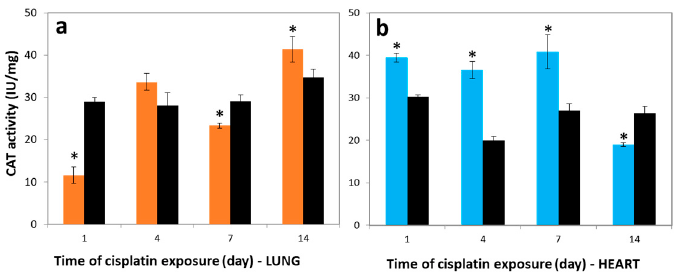
Figure 3. Catalase (CAT) activity in ( a ) lung and ( b ) heart tissues over time. Lung ( ⎯ ⎯ ) and heart ( ⎯ ⎯ ) tissues of treatment group, and controls ( ⎯ ⎯ ). These results are expressed as mean ± SD ( n = 6). *Significantly different ( p < 0.05) from control.